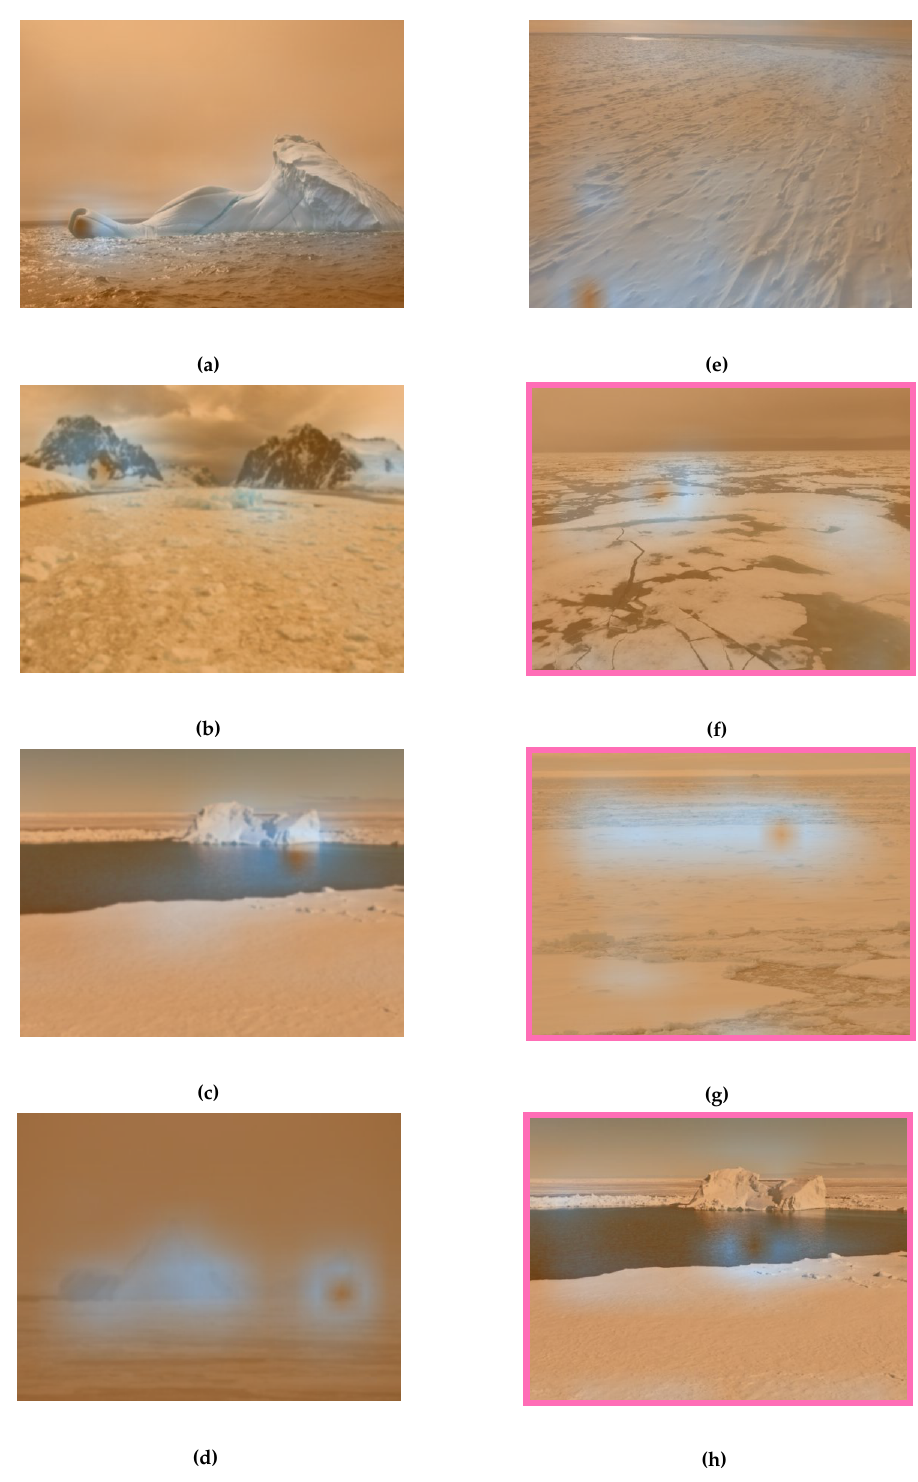
Figure 10. GradCAM-images showing which part of the original image that pushes the network towards classifying the image as icebergs (( a ) – ( d )) or ice floes (( e ) – ( h )). Orange areas have little impact, while light blue areas are important. Images with pink borders were not correctly classified by the network. Image rights: a: Natalie Lucier, b: SF Brit, c: Sergey Dolya, d: Roger Skjetne, e: Sveinung Løset, f: Alex Cowan, g: SAMCoT Project, h: Sergey Dolya